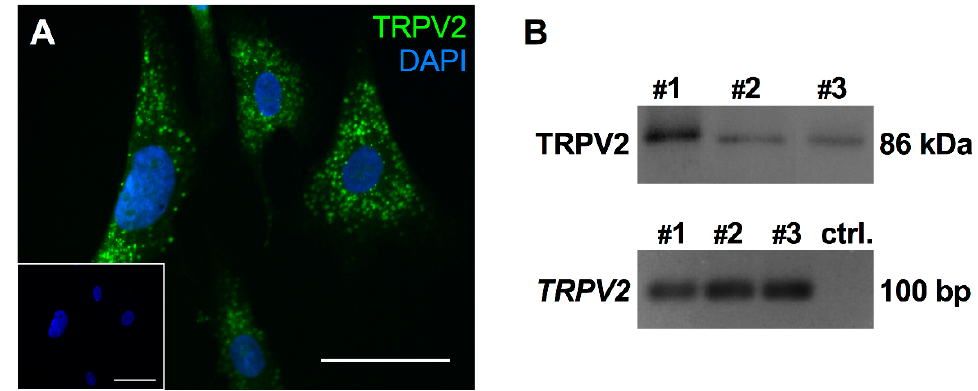
Figure 1. TRPV2 expression was confirmed in cultured HTPCs. ( A ) On the cellular level, TRPV2 exhibited a scattered expression pattern. Scale bar 10 µm. ( B ) In cultured HTPCs, expression of TRPV2 was detected by Western blot with a single band of the expected size (86 kDa) and RT-PCR showed clear bands at ~100 bp. Sequencing of the PCR-product validated expression of TRPV2 . Bands obtained from three individual patients (#1–3) and negative control without cDNA in the RT-PCR reaction